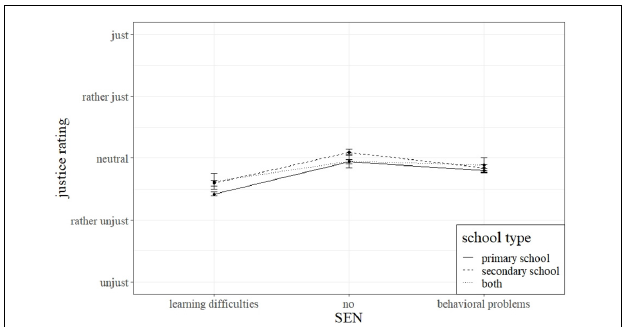
FIGURE 3 | Interaction of school type mainly taught in and special educational need.